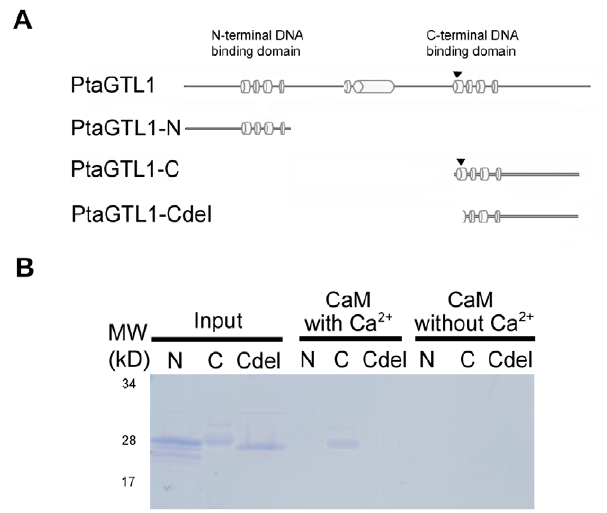
Figure 5. PtaGTL1-C interacts with CaM in a Ca 2 + -dependent manner. A. Schematic diagrams of PtaGTL1 fragment proteins: PtaGTL1-N, PtaGTL1-C, and PtaGTL1-Cdel fragments are illustrated. PtaGTL1-N and PtaGTL1-Cdel fragments do not include CaM-binding site. Arrowheads indicate the position of putative CaM-binding site. B. Ten micrograms of purified PtaGTL1-N, PtaGTL1-C, and PtaGTL1-Cdel were incubated with CaM-agarose in a buffer solution with or without 2 mM CaCl 2 . After extensive washing with the buffer solution, the proteins bound to CaM-agarose were eluted with elution buffer containing 10 mM EGTA and separated by SDS-PAGE (12% Tris-HCl separating gel). Inputs indicate 10 m g of protein fragments used for CaM-binding assays.